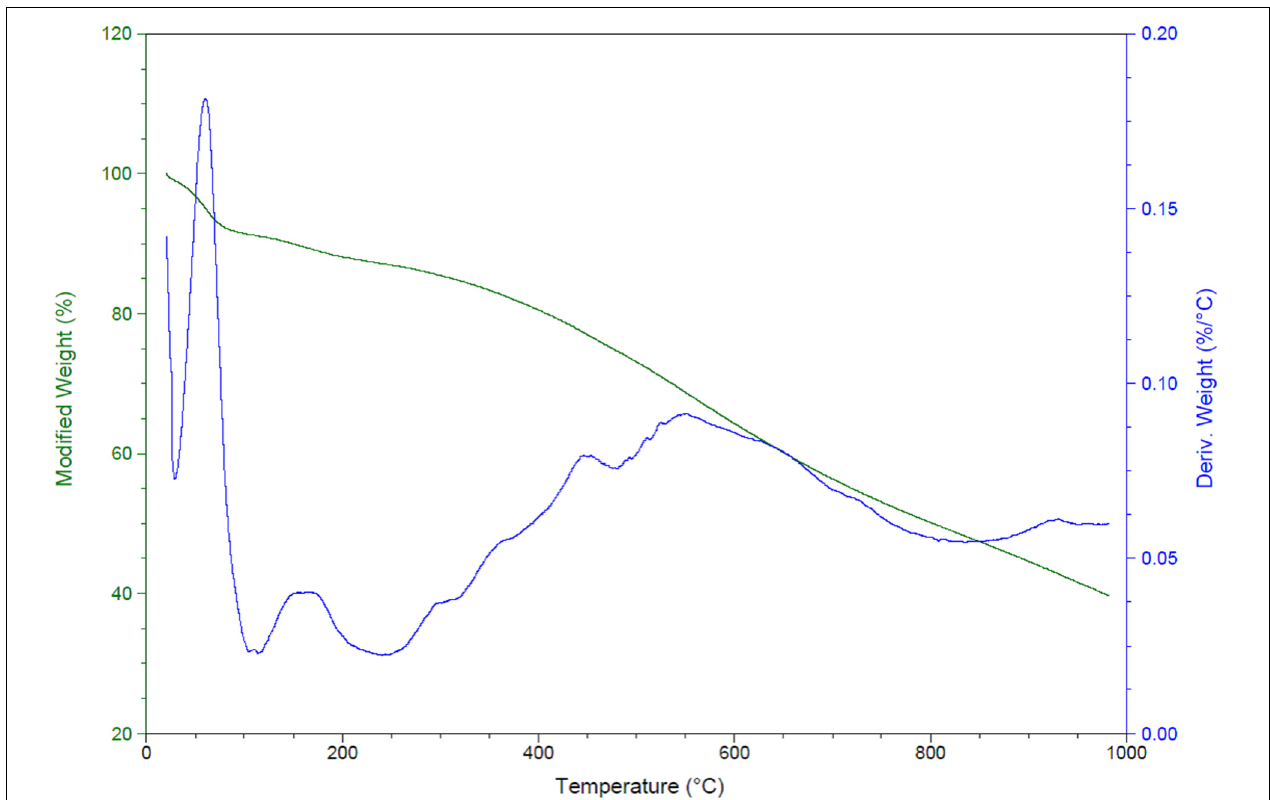
FIGURE 6 | Loading of amine content during calcination of TriFeOMC samples.